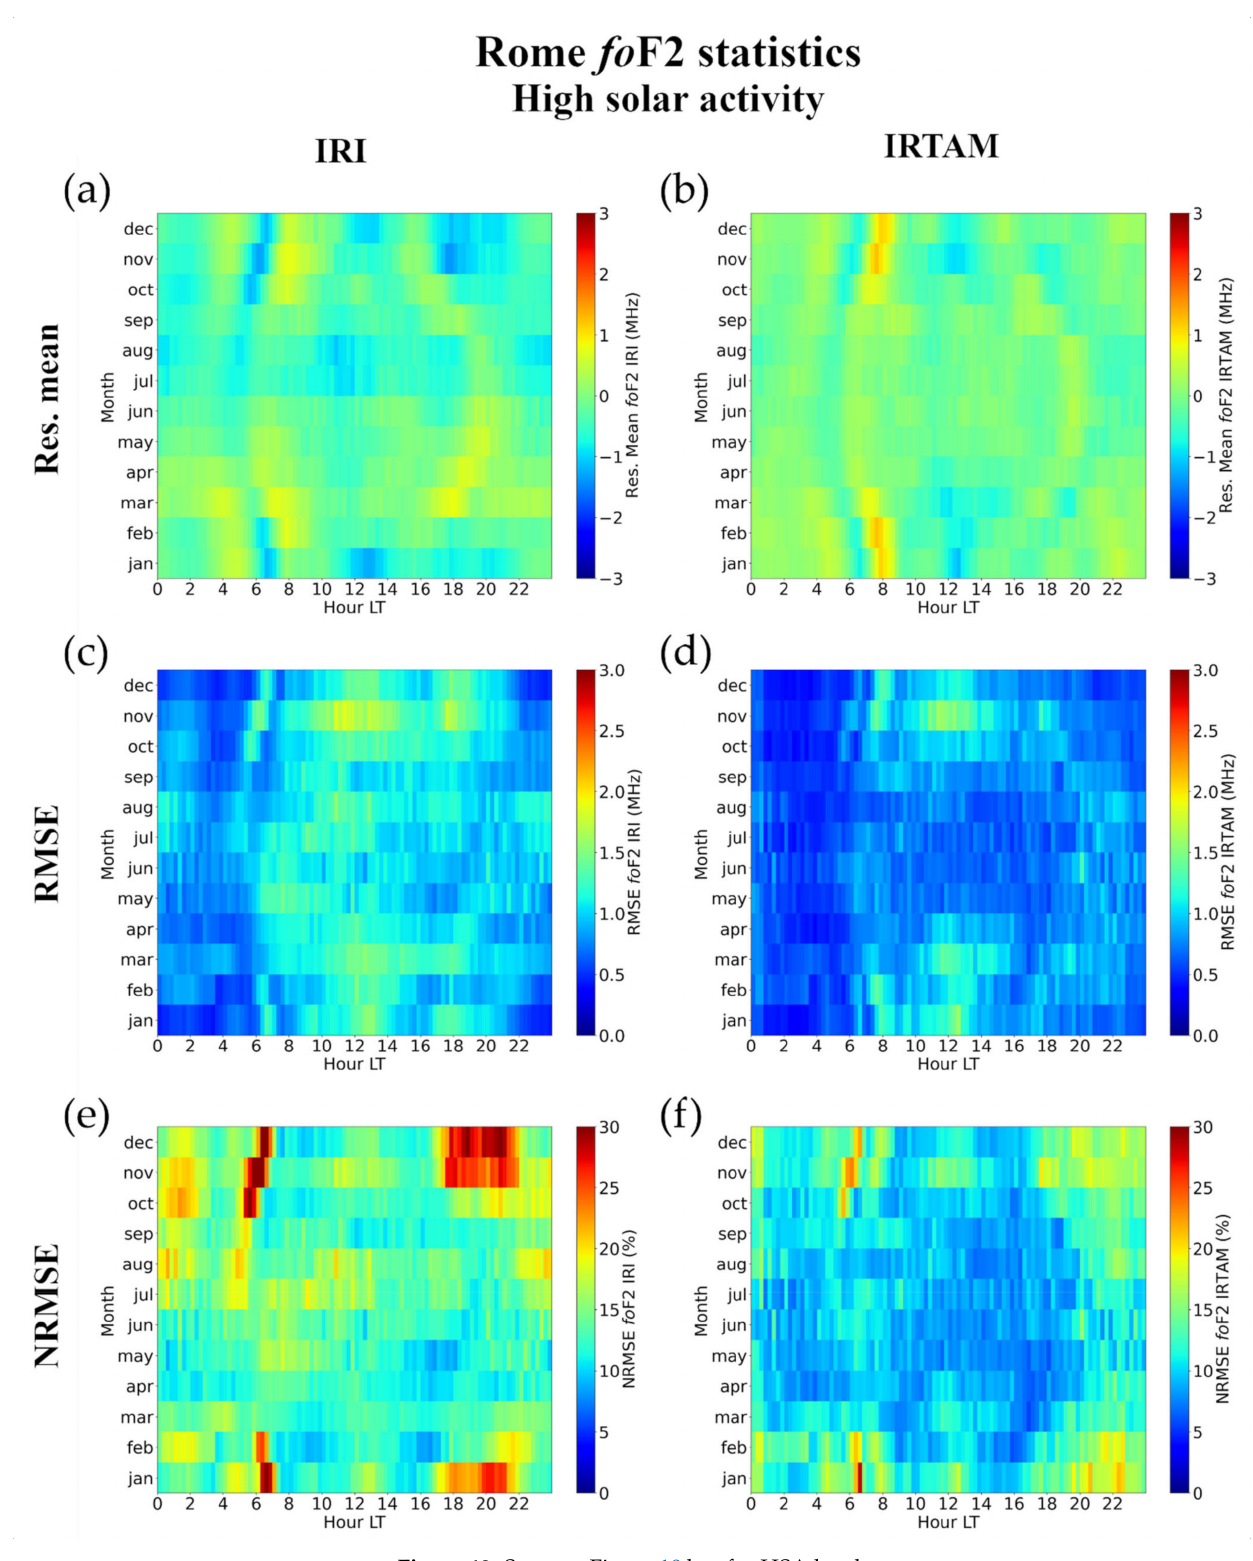
Figure 12. Same as Figure 10 but for HSA